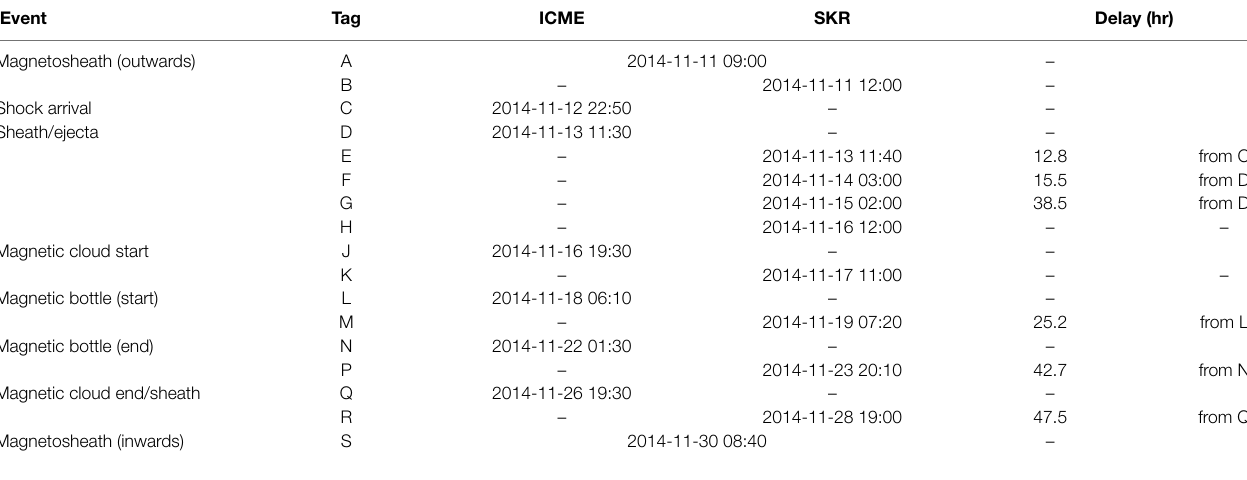
TABLE 2 | Timings of the major signatures of the ICME and SKR. The first column are the tags shown on Figure 4 . Times are given in the format YYYY-MM-DD hh:mm. Event Tag ICME Magnetosheath